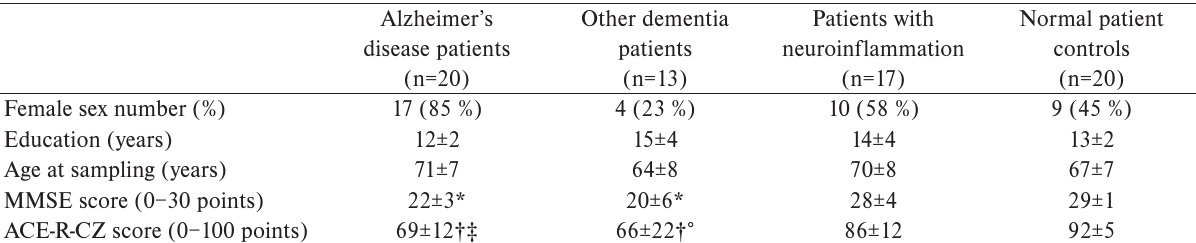
Table 1. Demographic and cognitive characteristics of the